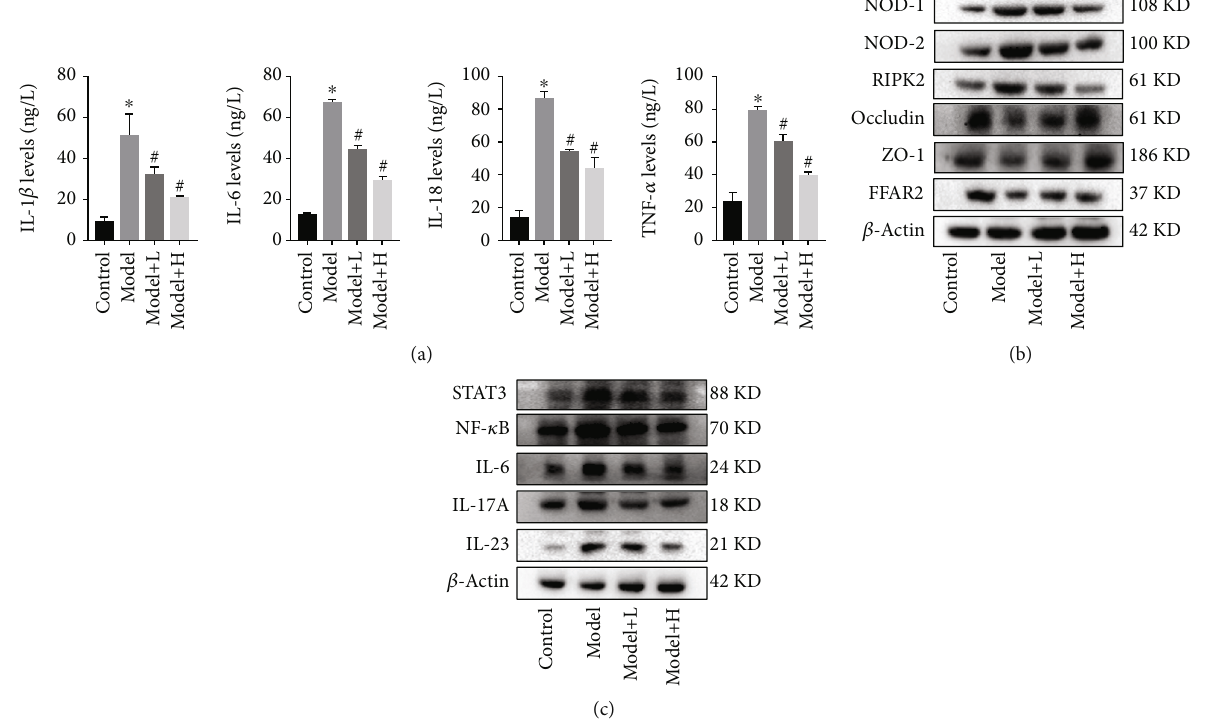
Figure 6: Qinghua Jianpi Recipe regulated the expression of pathway-related proteins and inhibited the expression of in fl ammatory factors in intestinal tissue. ELISA was used in testing the expression of in fl ammatory factors in intestinal tissue (a); Western blot analysis was used to detect related protein ( x ± s , n ≥ 3 ) (b, c). β -Actin was used as an invariant control for equal loading. ∗ P < 0 : 05 and # P < 0 : 05 , the di ff erence was statistically signi fi